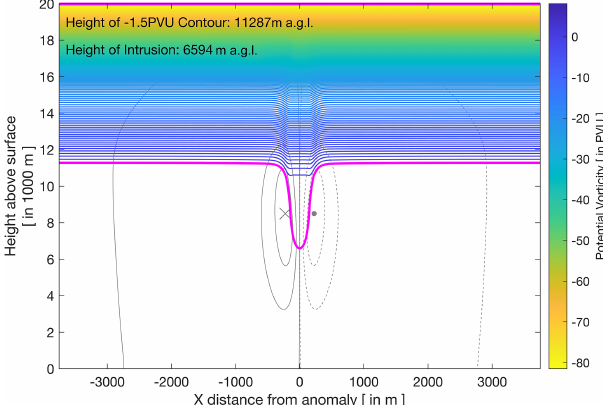
Figure 5. Stratospheric intrusion with a radial width of 200km and depth of 5000m from the dynamical tropopause specified at 12500ma.g.l. Meridional wind velocities are given in 4ms − 1 in- tervals shown by the grey contours. Solid grey contours and the “X” indicate winds moving into the page, whilst dashed grey contours and the “dot” indicate winds coming out of the